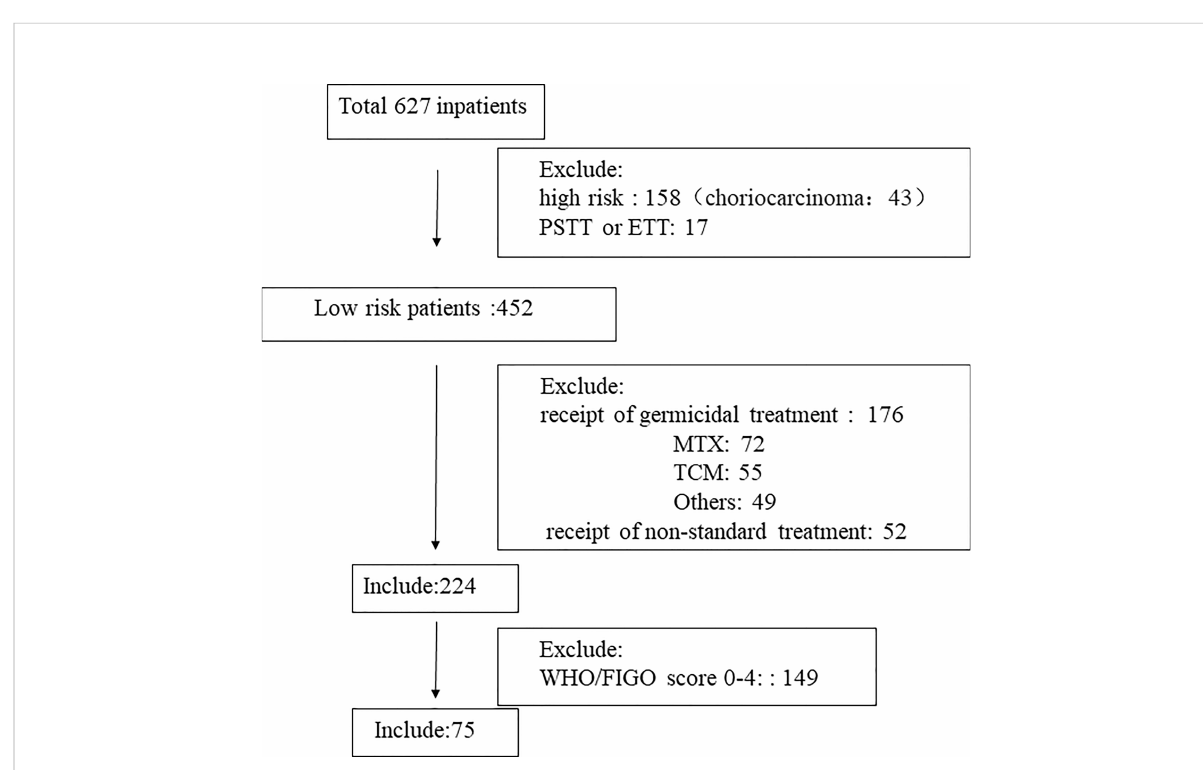
FIGURE 1 Flow diagram showing the derivation of the patient population. TCM, Traditional Chinese Medicine; MTX, methotrexate; PSTT, placental site trophoblastic tumor; ETT epithelioid trophoblastic tumor.